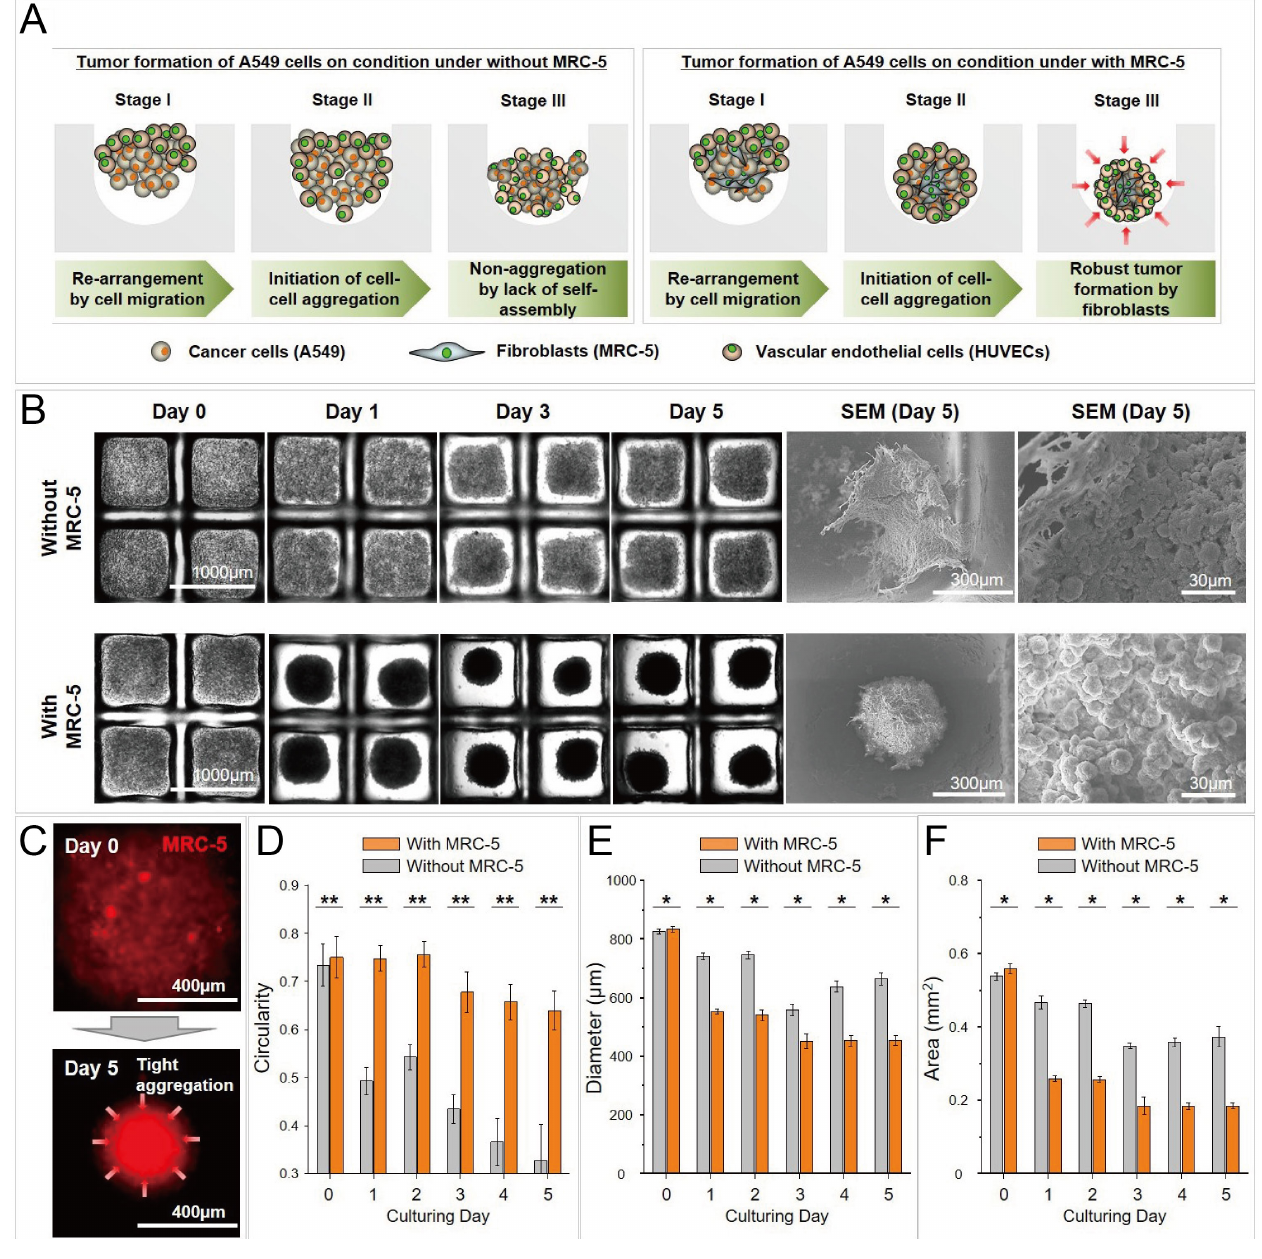
Figure 14. Cancer spheroids formed by co-culture of A549 (human lung cancer cells) and MRC-5 (fibroblasts), and tri-culture of A549, MRC-5, and human umbilical vein endothelial cells (HU- VECS) [89]. ( A ) The schematic view of the formation of cancer spheroids by co-culture and tri- coculture. ( B ) Bright-field pictures and SEM pictures of cancer spheroids by co-culture and tri-culture in concave microwells. ( C ) Fluorescent pictures of cell aggregates, in which the MRC-5 cells were labeled by a red cell tracker. Comparison of circularity ( D ), diameter ( E ) and area ( F ) of cancer spheroids by co-culture and tri-culture. * p < 0.05 and ** p < 0.005. Reprinted (adapted) from [89] under the terms of the Creative Commons Attribution